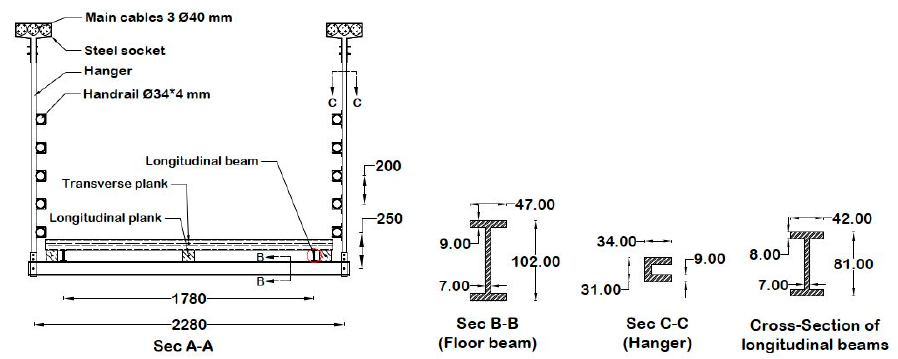
Figure 5. Cross-sections and dimensions of the footbridge structural elements (in mm).